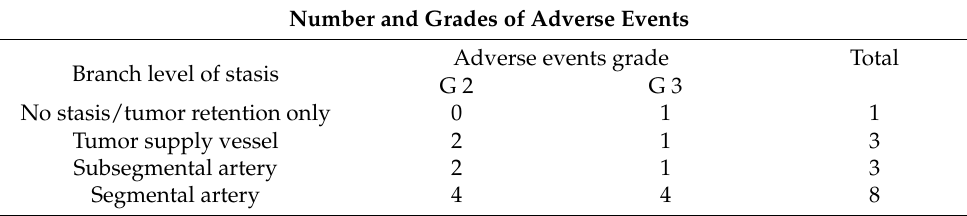
Table 5. Branch level of temporary stasis with the incidence of adverse